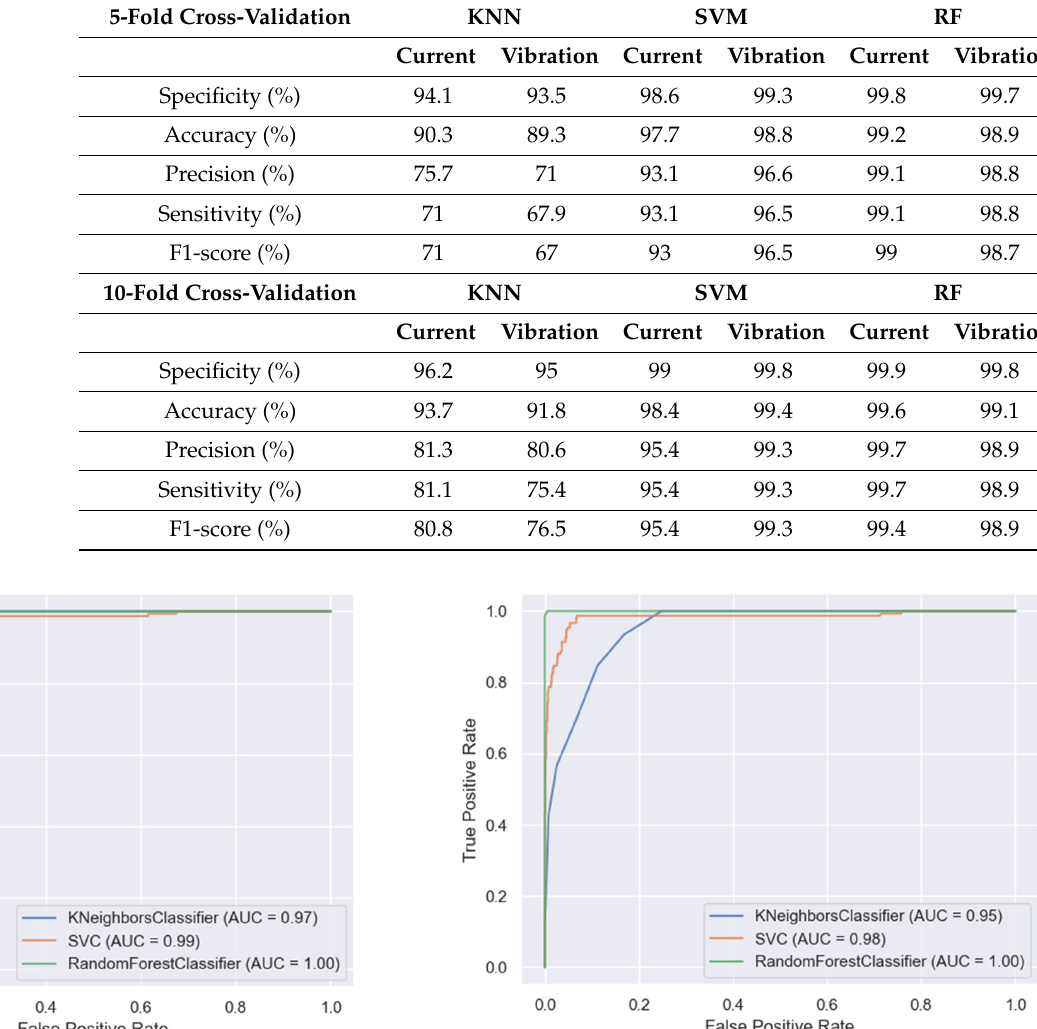
Table 8. Classification results applying genetic algorithm.